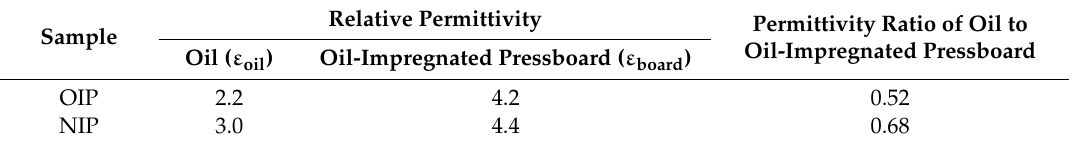
Table 3. The relative permittivities of oil samples and pressboard